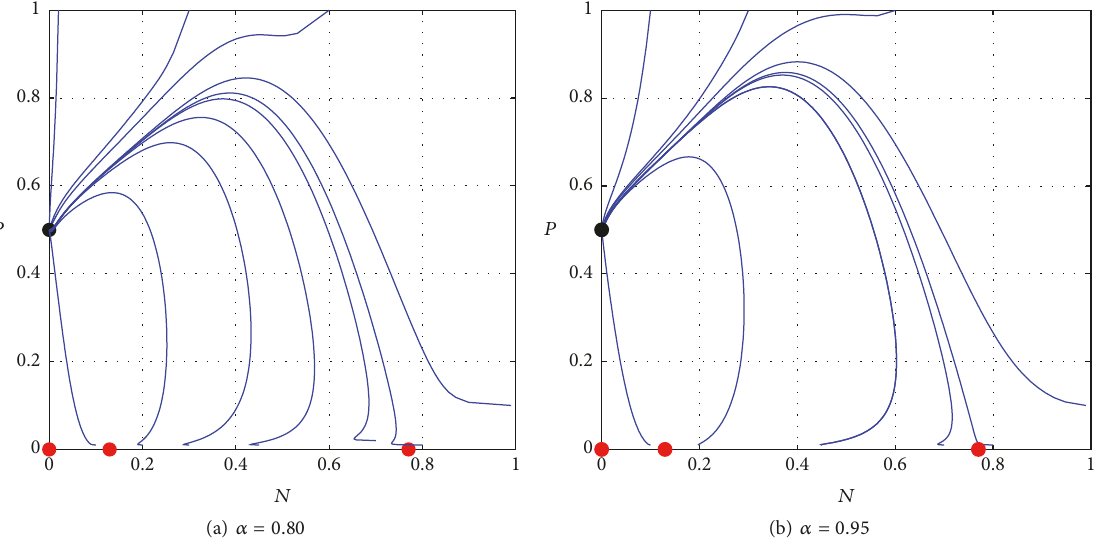
Figure 1: Phase portrait of system (6). The values of parameters are 𝑠 = 1 , 𝑘 = 0.5 , 𝑚 = 0.2 , ℎ = 0.1 , 𝜔 = 0.7 , 𝑎 = 1 , 𝑏 = 0.5 , 𝑐 = 0.05 , and Δ𝑡 = 0.1